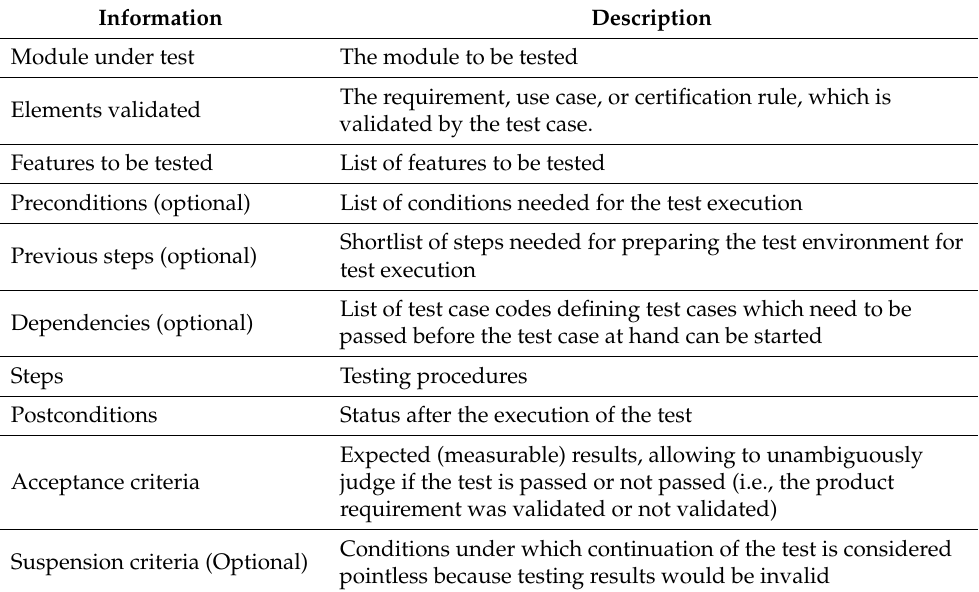
Table 3. Use case information template.